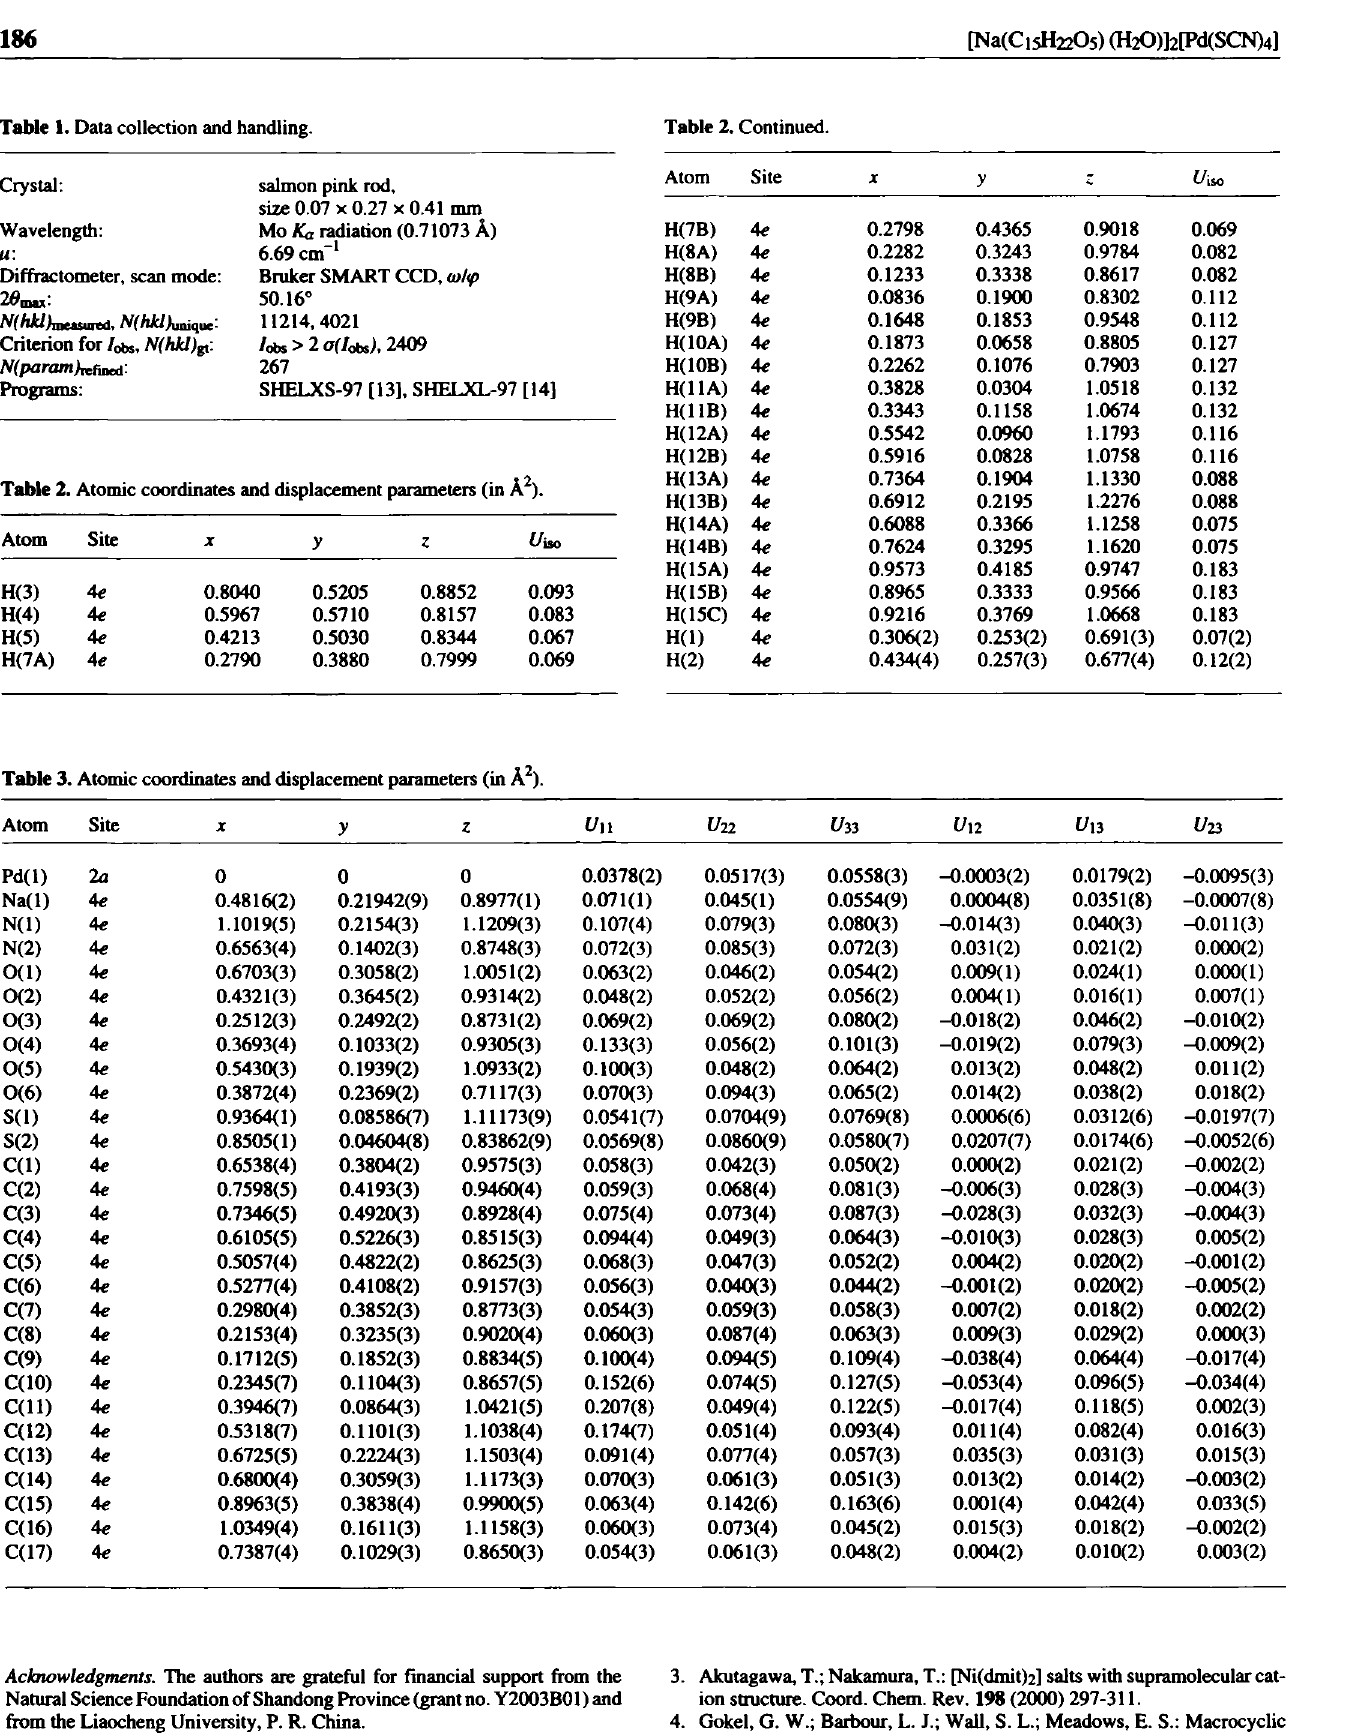
Table 1. Data collection and handling. Table 2. Continued.